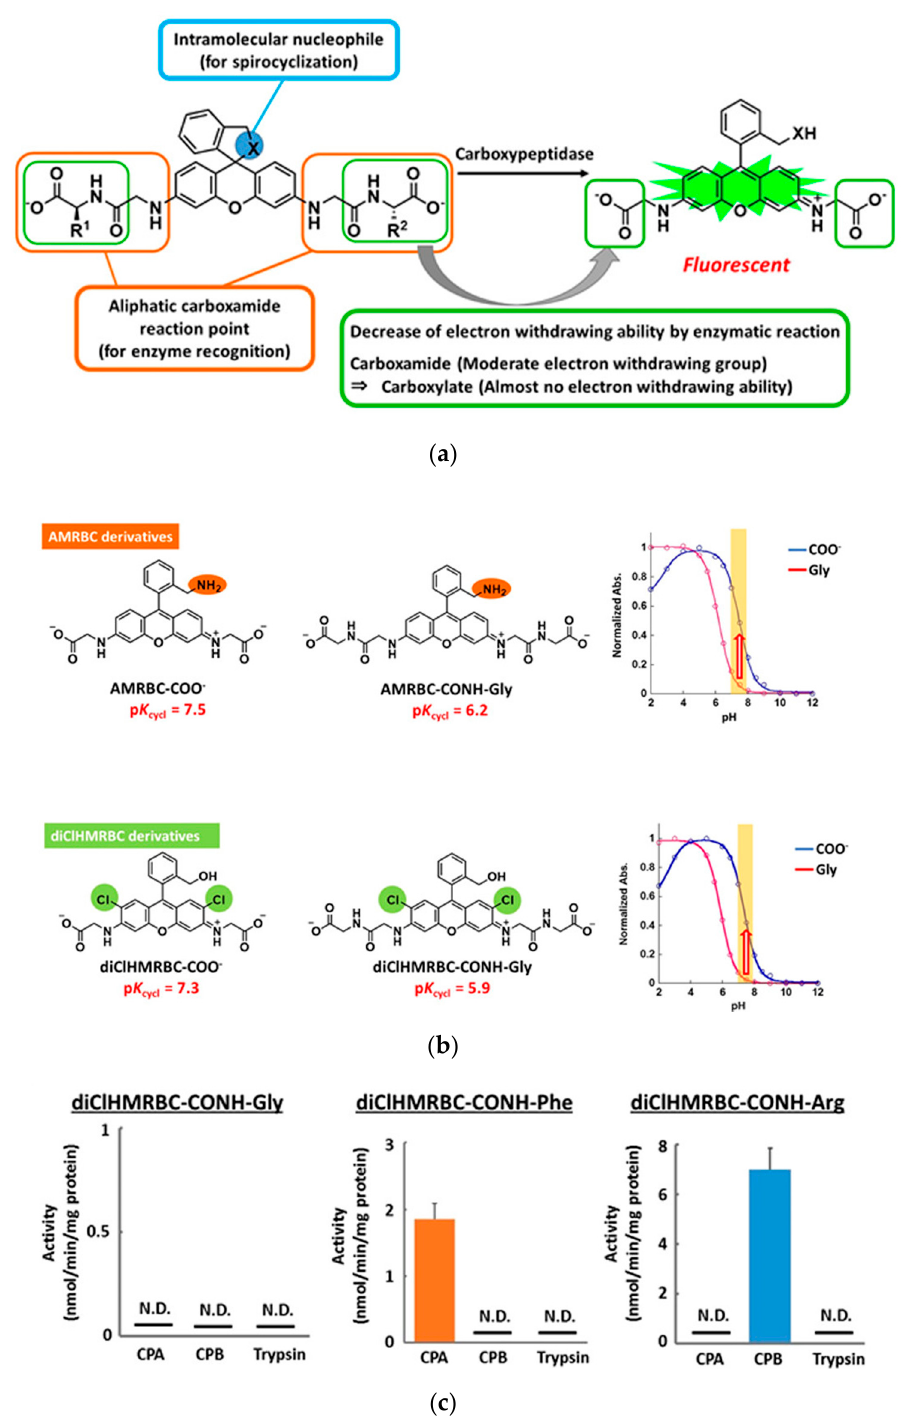
Figure 4. Novel probes for the detection of carboxypeptidases: ( a ) Molecular design of an activatable fluorescent probe for CPs; ( b ) AMRBC and diClHMRBC analogues and the change in pK cycl ; ( c ) Activation of diClHRBC-CONH-Gly , diClHMRBC-CONH-Phe , or diClHMRBC-CONH-Arg with CPA, CPB or trypsin. Adapted with permission from [107]. Copyright (2018) American Chemical